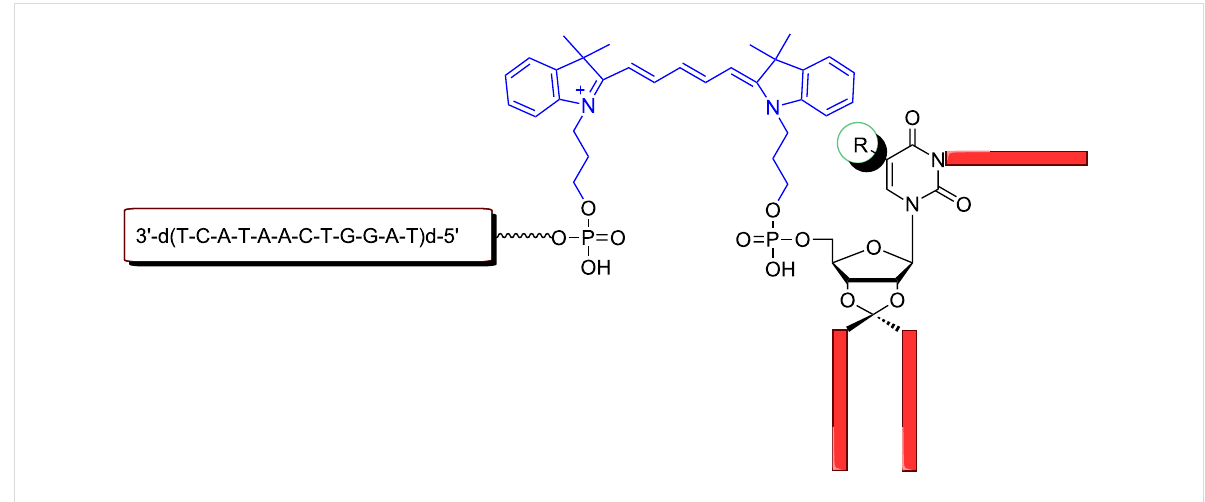
Figure 1: General structure of the fluorophore-labeled lipo-oligonucleotides and positions of lipophilization of the pyrimidine β -D-ribonucleoside head groups 1 – 3 [18].